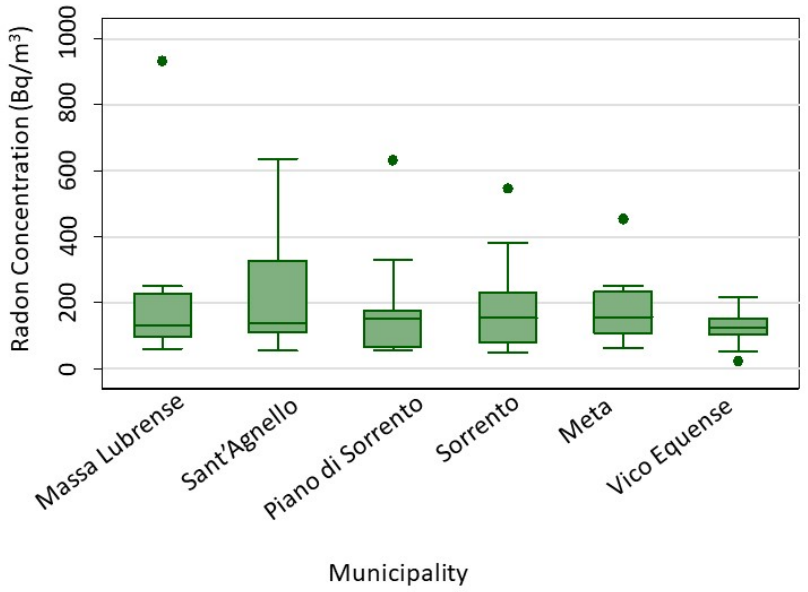
Figure 5. Box plot of Rn concentration in Bq/m 3 by municipality. The continuous line denotes the median, the boxes enclose the quartiles, the dots represent the outliers.